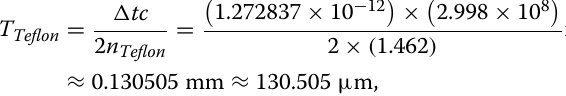
Table 2 Presentation of the real and the experimental values of thickness for the different delamination defects for 5 samples with the standard error (SE) and relative error Sample